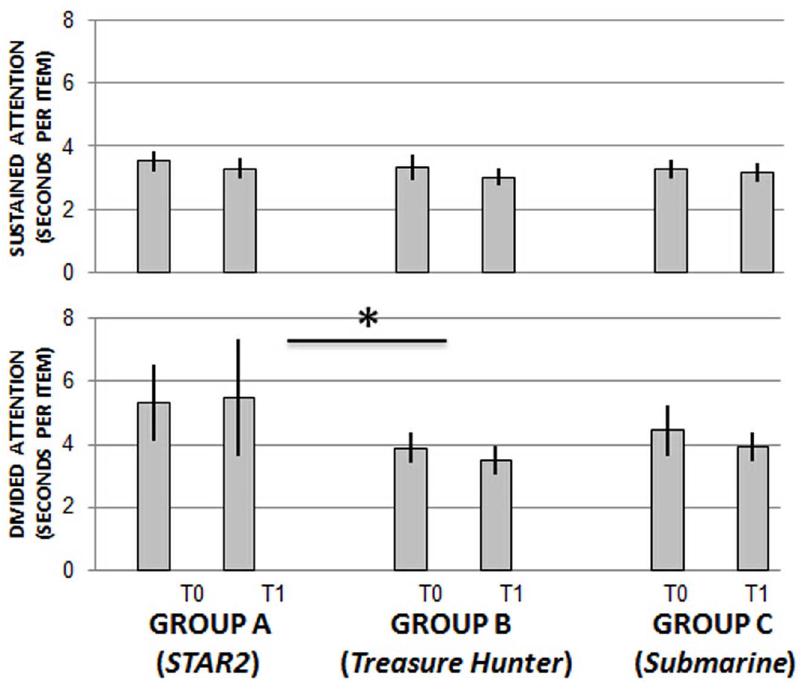
Figure 5. Sustained and divided attention task scores before and after training. There was no significant change in the measure of sustained attention after training. There was a significant between groups difference on the divided attention task for Group A compared to Group B but there was no effect of time or interaction (* p , 0.05). n=20 per group.